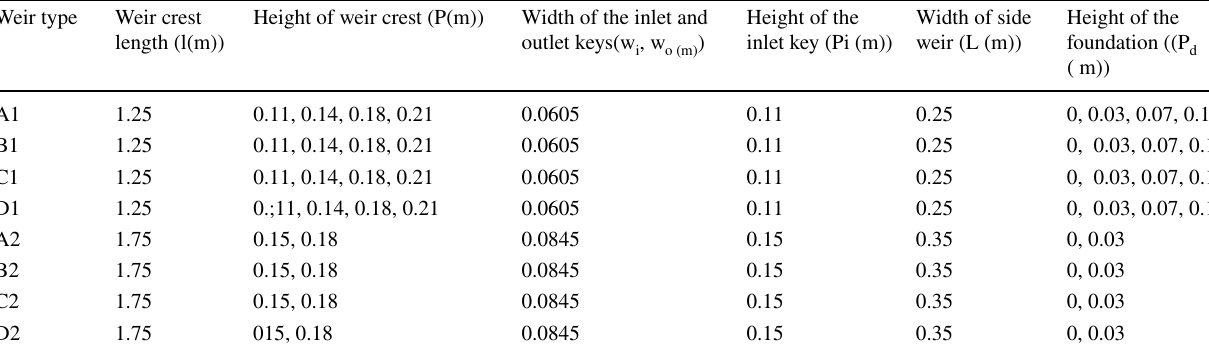
Table 1 Characteristics of the used weirs Weir type